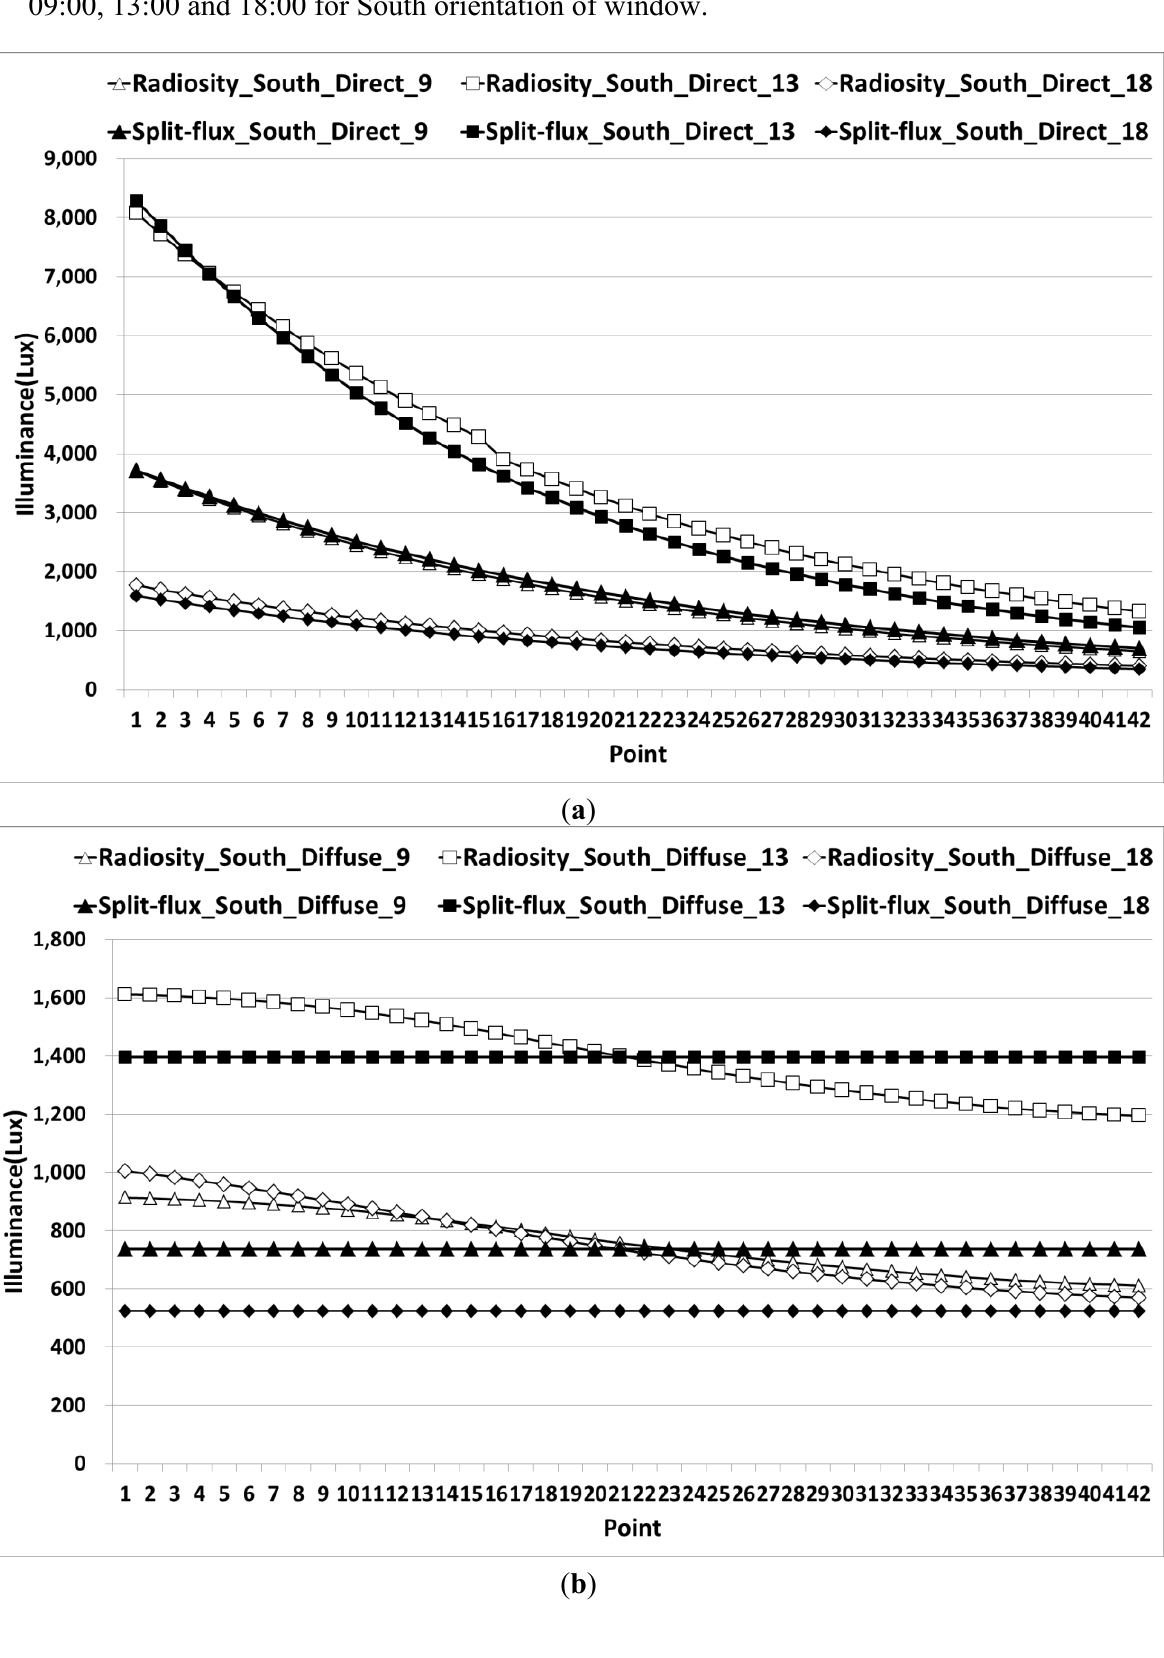
Figure 6. Direct and Diffuse interior illuminance from Split-flux and Radiosity at